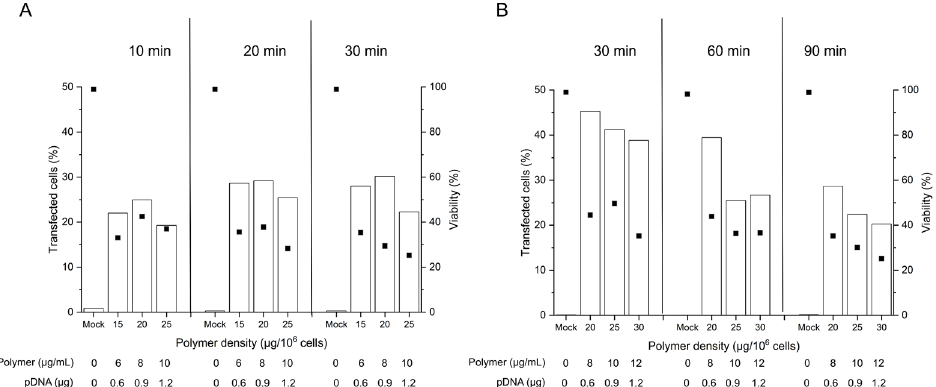
Figure 3. Influence of the polyplex contact time on transfection efficiency and viability. Cell number during transfection: 2 × 10 5 cells (day 4 post-thawing), tube transfection protocol. pDNA corresponds to the amount of plasmid per tube. Contact time: as indicated, N/P: 10, transfection volume: 0.5 mL. TE (bars) and viability (squares) were measured 48 h post-transfection. Mock: cells subjected to mock transfection. n = 1. Cell viability on the day of transfection: 80%, group A ( A ) and 93%, group B ( B ).